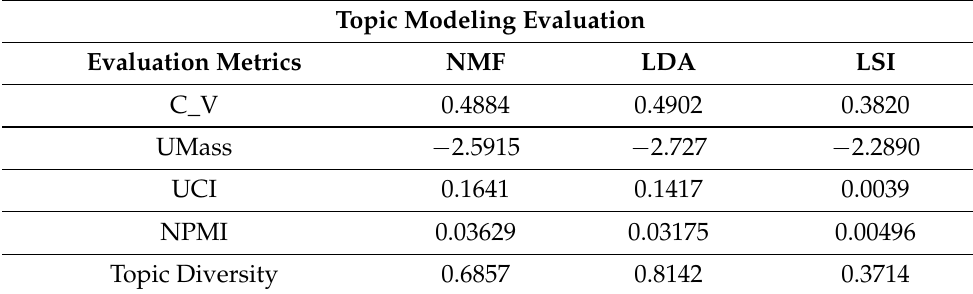
Table 2. Topic models evaluation for T = 7